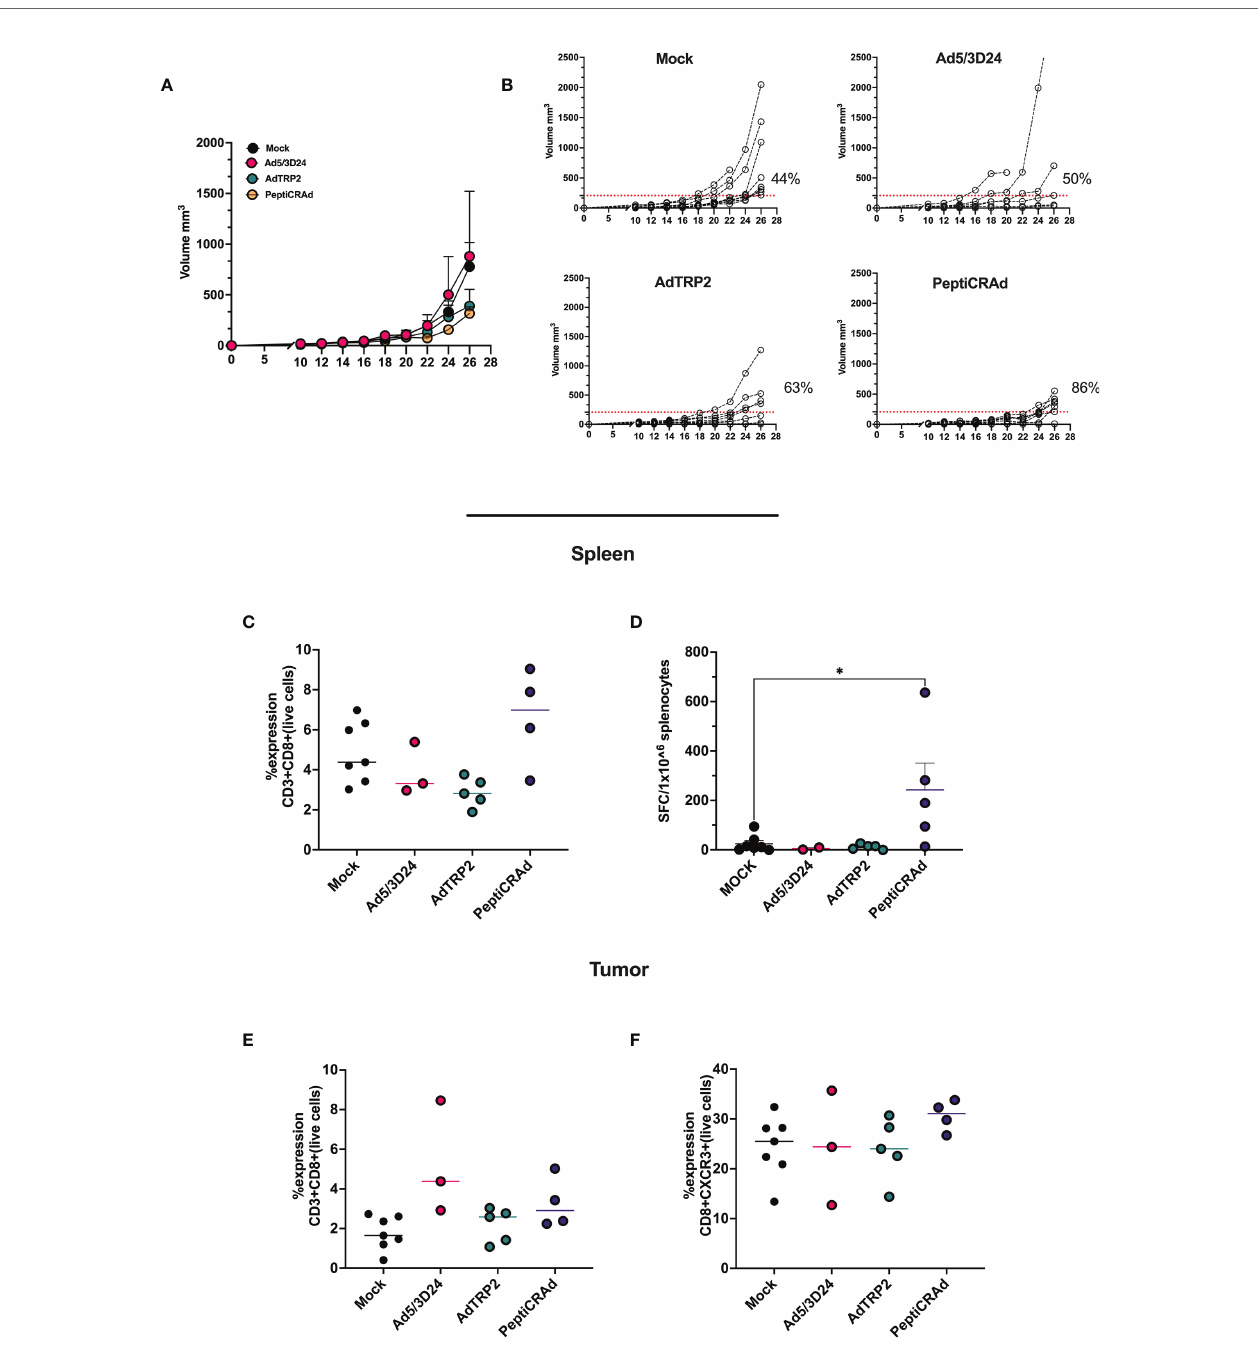
FIGURE 4 | Intratumorally administration of PeptiCRAd induced tumor regression and immunological modulation (A) Ad5/3 D 24, AdTRP2 or PeptiCRAd was given intratumorally at 9,11,13 and 15 days post tumor implantation. The tumor growth was followed until the end of the experiment and the tumor size is presented as the mean ± SEM. Statistically difference was assessed with two-way ANOVA (ns P > 0.05, *P ≤ 0.05, **P ≤ 0.01, ***P ≤ 0.001, P ≤ 0.0001). (Mock n=9, Ad5/3 D 24 n=6 AdTRP2 n=8 or PeptiCRAd n=7) (B) Single tumor growth for single mouse for each treatment group is depicted. A threshold of 209 mm 3 was set to de fi ne the percentage of mice responding to the different therapies (red dotted line). The percentage of responders in each treatment group is shown on the right side of the dotted line. (The threshold was de fi ned as the median of the tumor size at the last day of the experiment in the Ad5/3 D 24 treated group). (C) Flow cytometry analysis of spleens from treated mice showing the frequency of CD8+T cells. Data are expressed as single dot for each mouse and median is reported (D) IFN- g ELISpot was performed on harvested splenocytes and individual response to TRP2 for each mouse is reported as IFN - g spot forming cells (SFC)/10 6 splenocytes. The data are depicted as dot plot and mean ± SEM is shown. Statistical analysis was performed with ordinary One-way ANOVA (ns P > 0.05, *P ≤ 0.05, **P ≤ 0.01, ***P ≤ 0.001, P ≤ 0.0001). The frequency of CD8+ (E) and CD8+CXCR3+ (F) was analyzed in TME through fl ow cytometry analysis and the data are shown as single dot for each mouse and median is